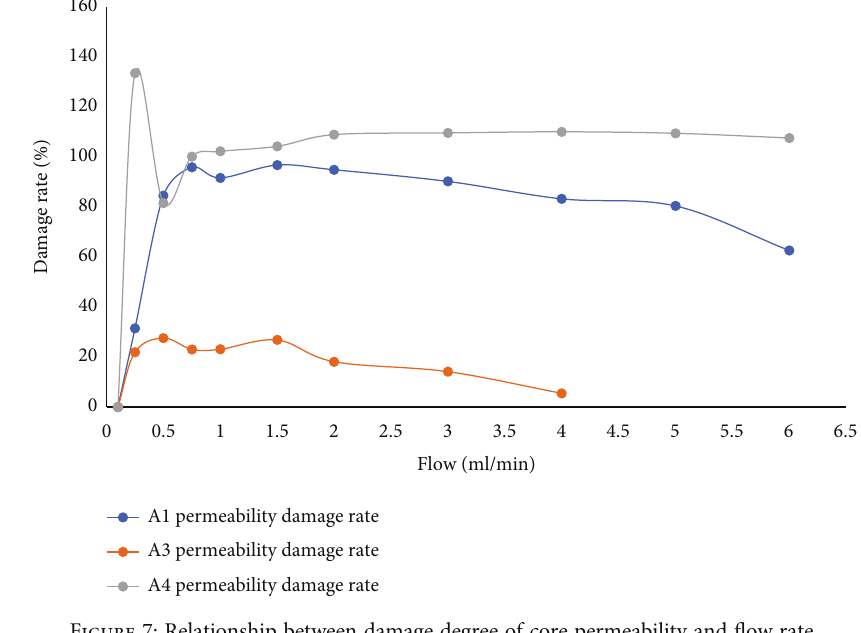
Figure 7: Relationship between damage degree of core permeability and fl ow